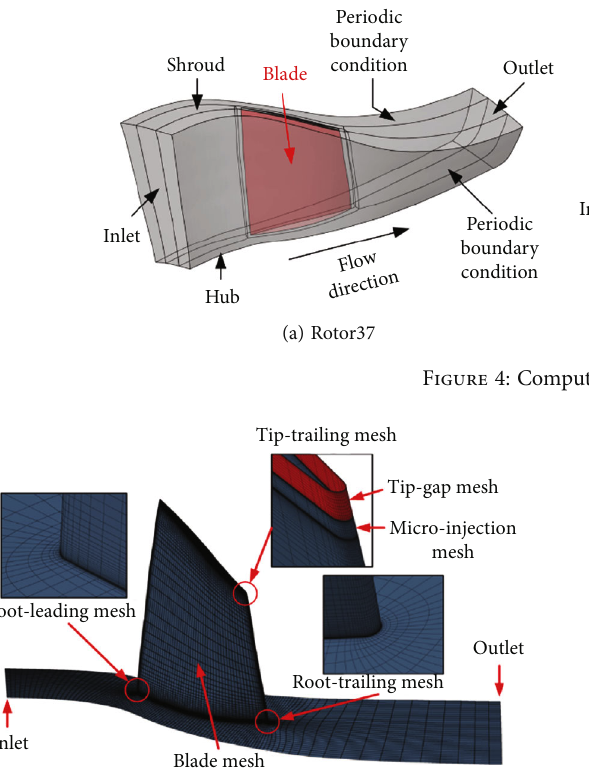
Figure 5: Schematic diagram of the grid.